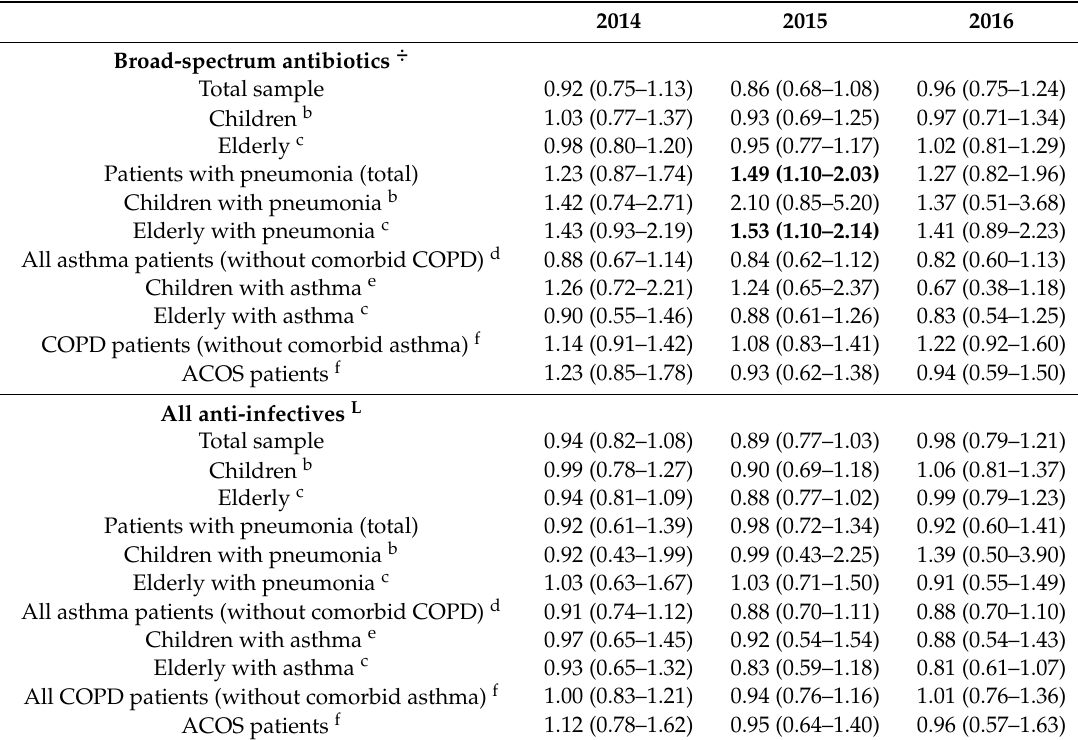
Table 5. Di ff erences (OR, 99% CI) a per year in antibiotic prescriptions between the livestock dense areas and control areas (statistically significant results in bold)